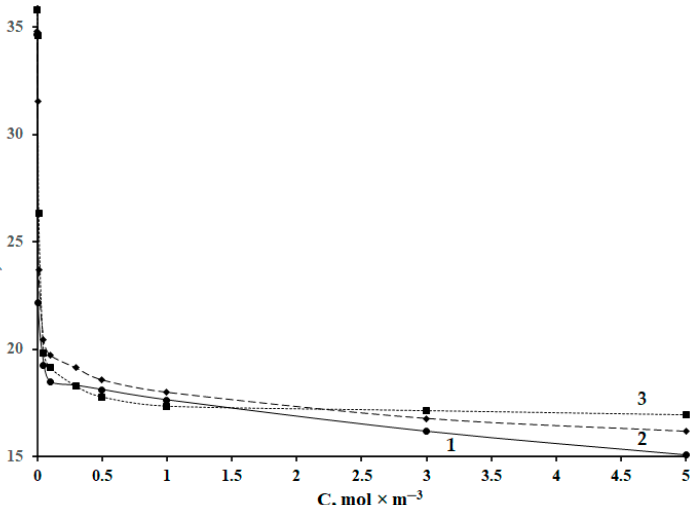
Figure 7. Surface tension isotherms at the water/toluene interface for amphiphilic copolymers of N-vinyl-2-pyrrolidone and allyl glycidyl ether obtained at various VP/AGE molar ratios in the reaction mixture: (1) − 9; (2) − 4.5; (3) − 3.